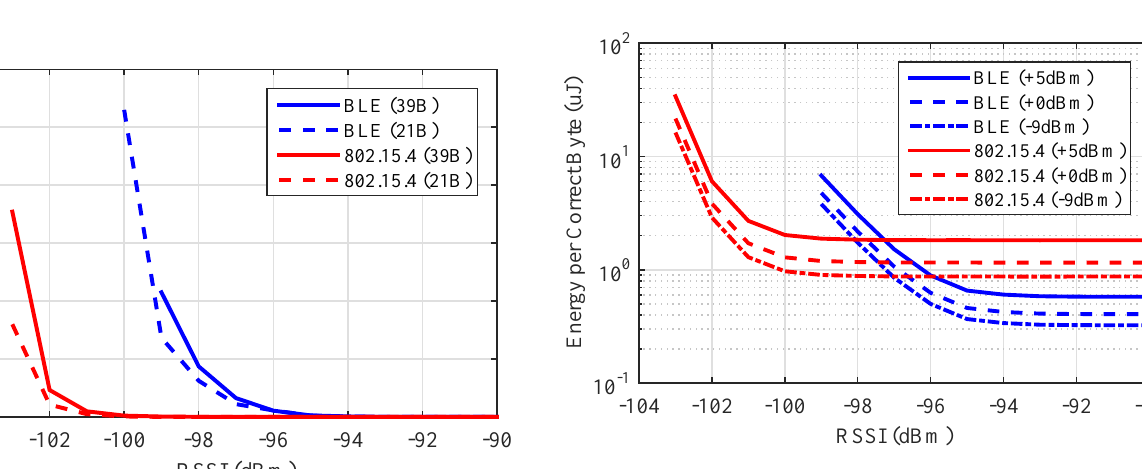
Figure 4. Energy consumption of the transmission of a successful byte (accounting for potential retransmissions) for various transmission power levels, considering L = 39 bytes.